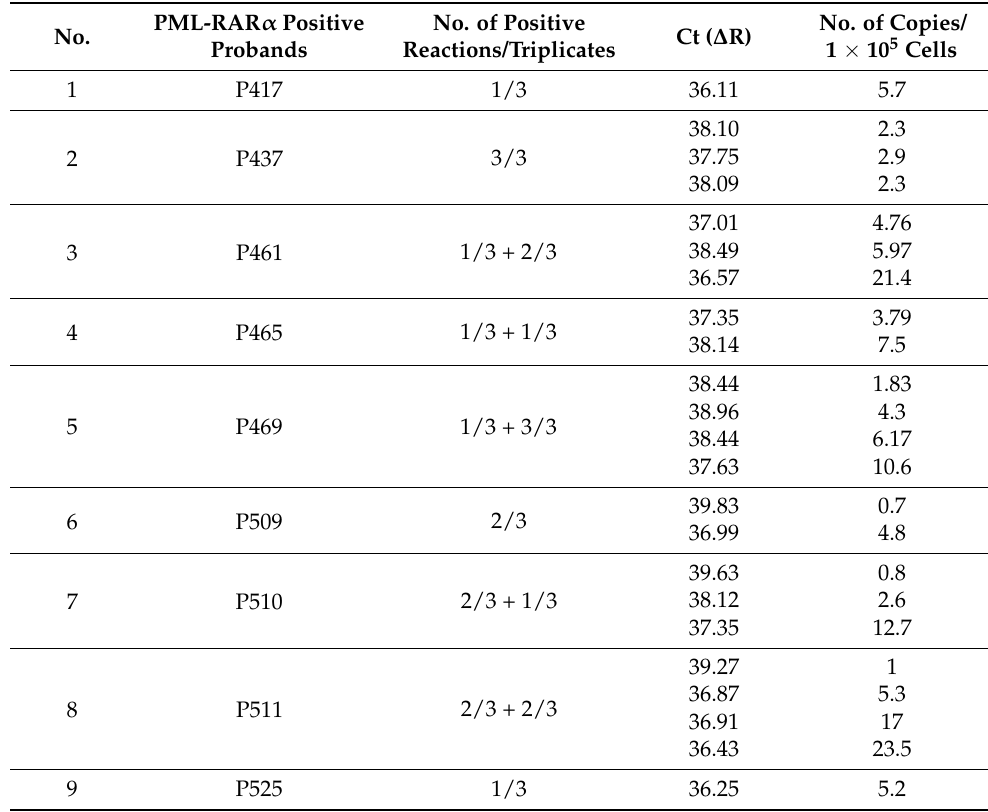
Table 2. RT-qPCR characteristics of PML-RAR α positive samples validated further by standard PCR and